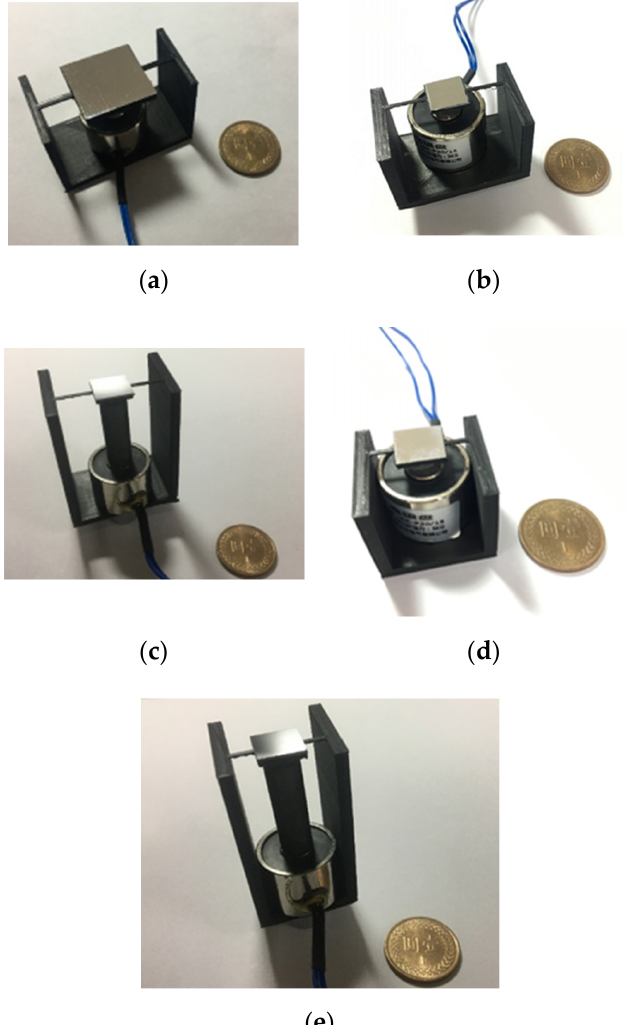
Figure 3. The photos of the fabricated devices: ( a ) Device A ( b ) Device B ( c ) Device C ( d ) Device D ( e ) Device E.